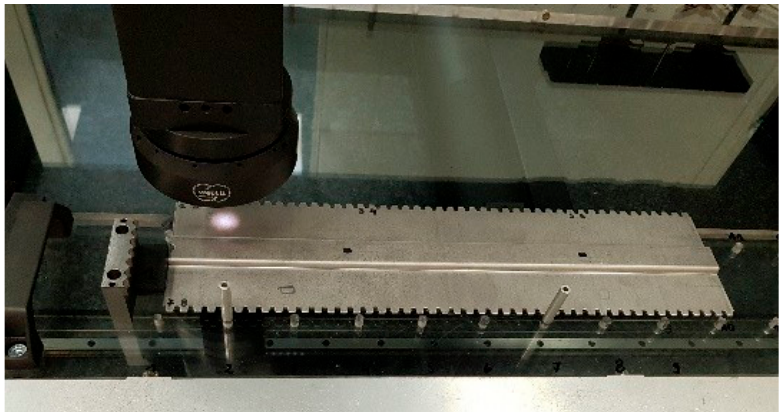
Figure 7. Measurement of the blank with the Multisensory Measuring Machine Werth Scope Check (blank placed on a glass plate) (own study).